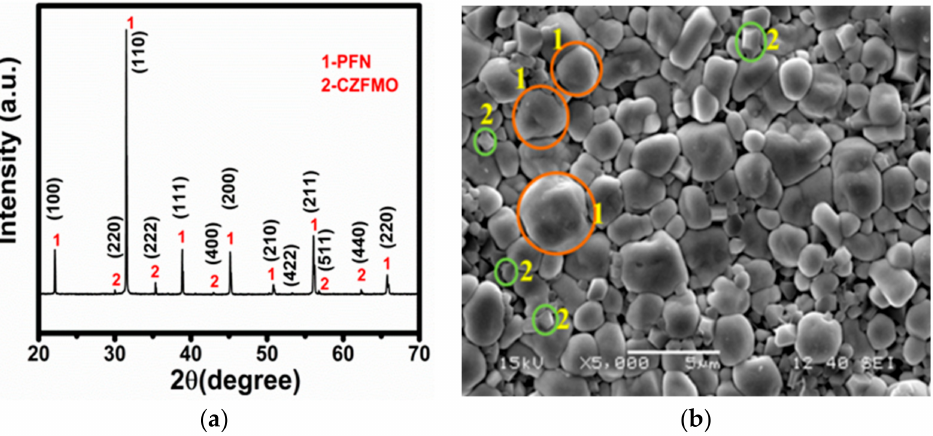
Figure 1. ( a ) Room temperature X-ray diffraction pattern and ( b ) SEM micrograph of PC10